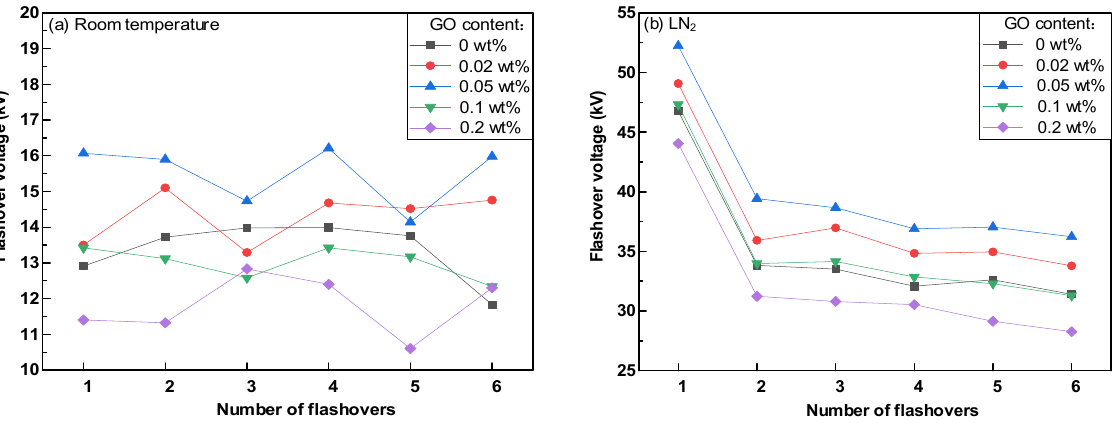
plitude during the discharge process was lower than that of the pure epoxy resin, espe-